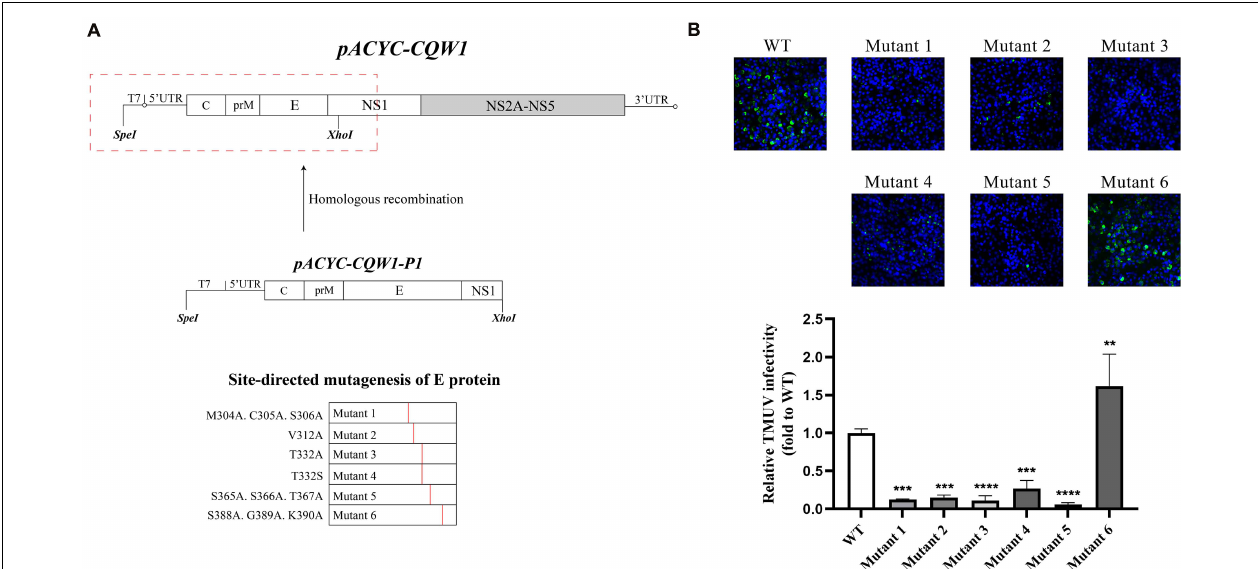
FIGURE 2 | The engineered mutations introduced in E protein affected the proliferation of the Tembusu virus (TMUV). (A) Schematic representation of infectious clone construction. The subclone pACYC-TMUV-P1, which includes the TMUV C, prM, E, and partial NS1 sequence, serves as a template for introducing mutations. Restriction enzyme sites Spe I and Xho I are used for fragment cloning. The fragments and pACYC-TMUV are connected by homologous recombination. (B) BHK-21 cells were transfected with in vitro -transcribed genomic RNAs and then analyzed by immunofluorescence straining at 72 h post-transfection, and mouse anti-TMUV serum polyclonal antibody was used as primary antibody. Green, TMUV; blue, nucleus. Results from one representative experiment out of three independent experiments are shown (upper). Quantification of virus infection rates by ImageJ (lower). Means and standard errors are from three microscopic field of views. Asterisks denote a statistically significant reduction in viral proliferation compared to that of the wild type (WT) (* p ≤ 0.05; ** p ≤ 0.005; *** p ≤ 0.001; **** p ≤